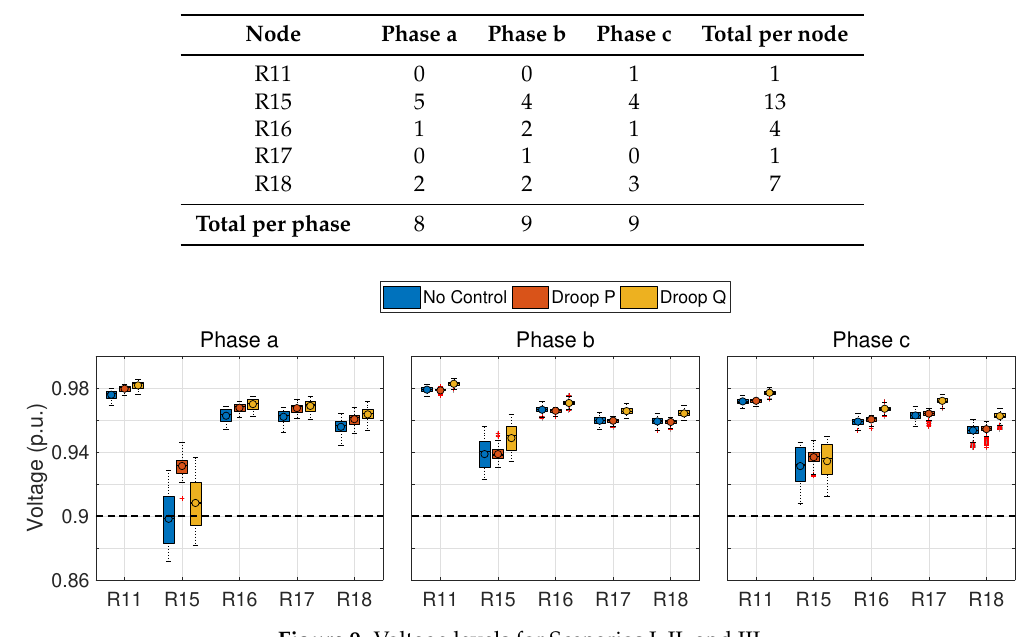
Figure 9. Voltage levels for Scenarios I, II, and